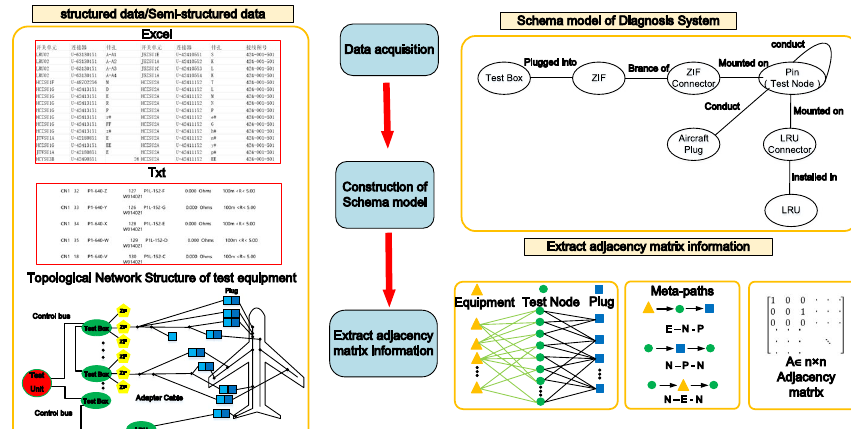
Fig. 1 Construction of the AWTE network model